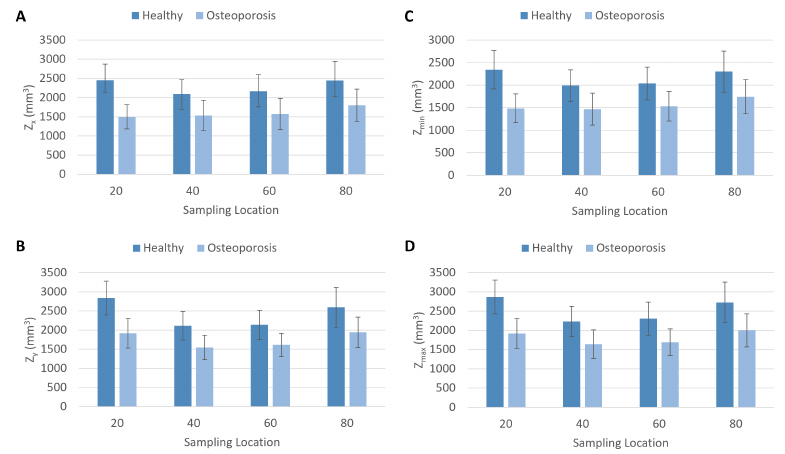
Figure 4. Plots of section modulus data from the healthy and osteoporosis experimental groups. ( A ) Section modulus about the x axis ( Z x ) . ( B ) Section modulus about the y axis ( Z y ) . ( C ) Minimum section modulus ( Z min ) . ( D ) Maximum section modulus ( Z max ) . Sampling location = percentage of biomechanical